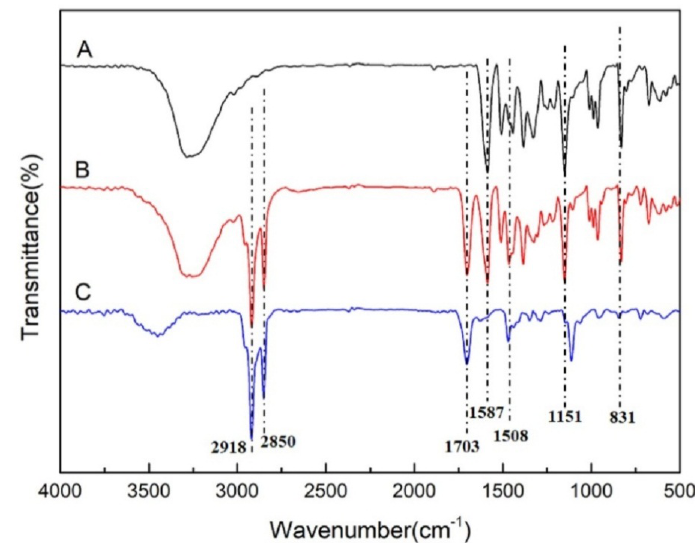
Figure 3. Fourier-transform infrared Raman (FTIR) spectra of RSV, RSV-SLN, and SLN; ( A ) FTIR spectra for RSV; ( B ) FTIR spectra for RSV-SLN; ( C ) FTIR spectra for SLN.